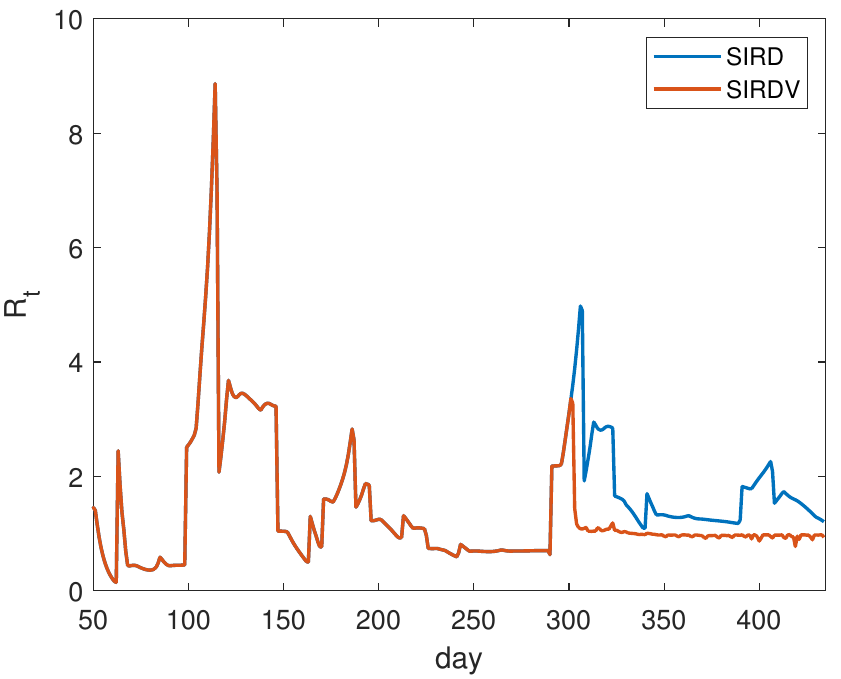
Figure 3. Daily trend of R t for ISR. Both cases of the SIRD and SIRDV models are investigated.